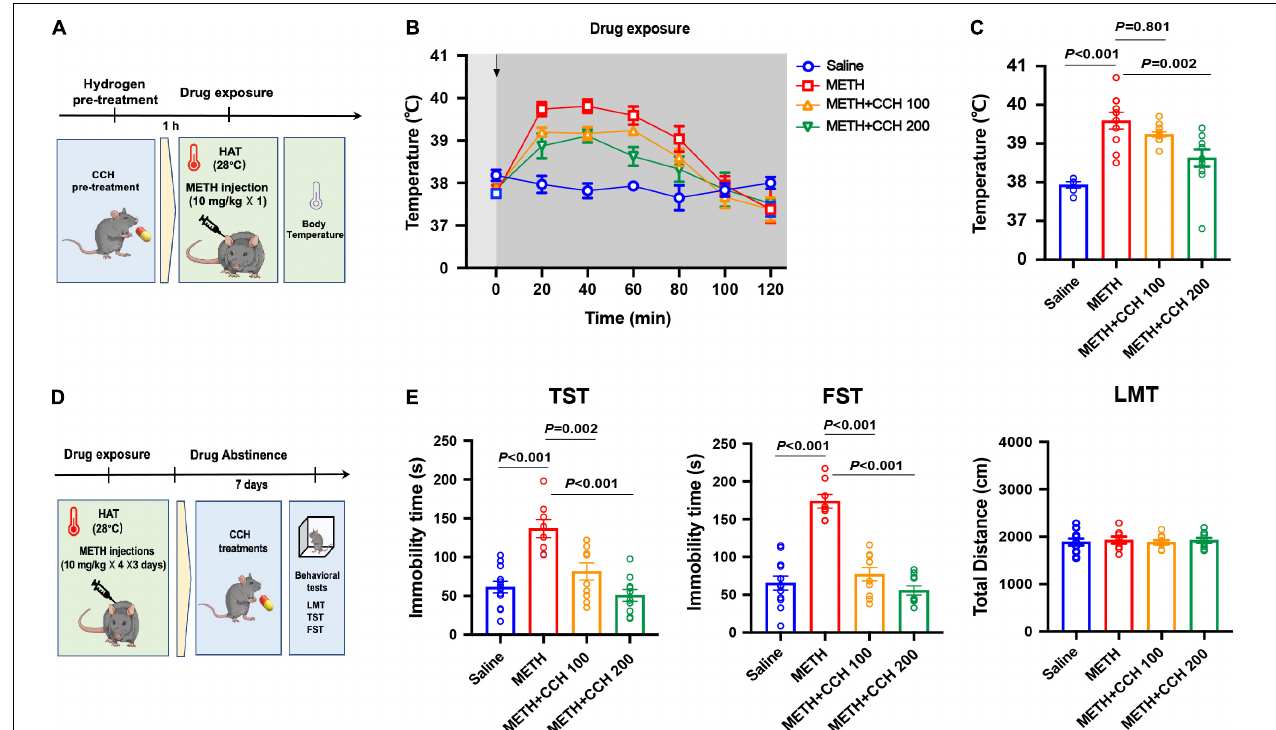
FIGURE 3 | Coral calcium hydride (CCH) administration inhibited METH-induced hyperthermia and depression-like behaviors. (A) Timeline of CCH pre-treatment, METH exposure and core body temperature determination. (B) The core body temperature was determined every 20 min after METH (10 mg/kg, i.p.) injection for 2-h ( n = 6, 10, 12, and 11). The arrows represent drug treatment. (C) The body temperature at 60 min after METH treatment was analyzed. (D) Timeline of METH exposure, therapeutic CCH treatment and behavioral tests. (E) Effect of CCH administration on METH-induced depression-like behaviors ( n = 8 per group). Data are expressed as the mean ±